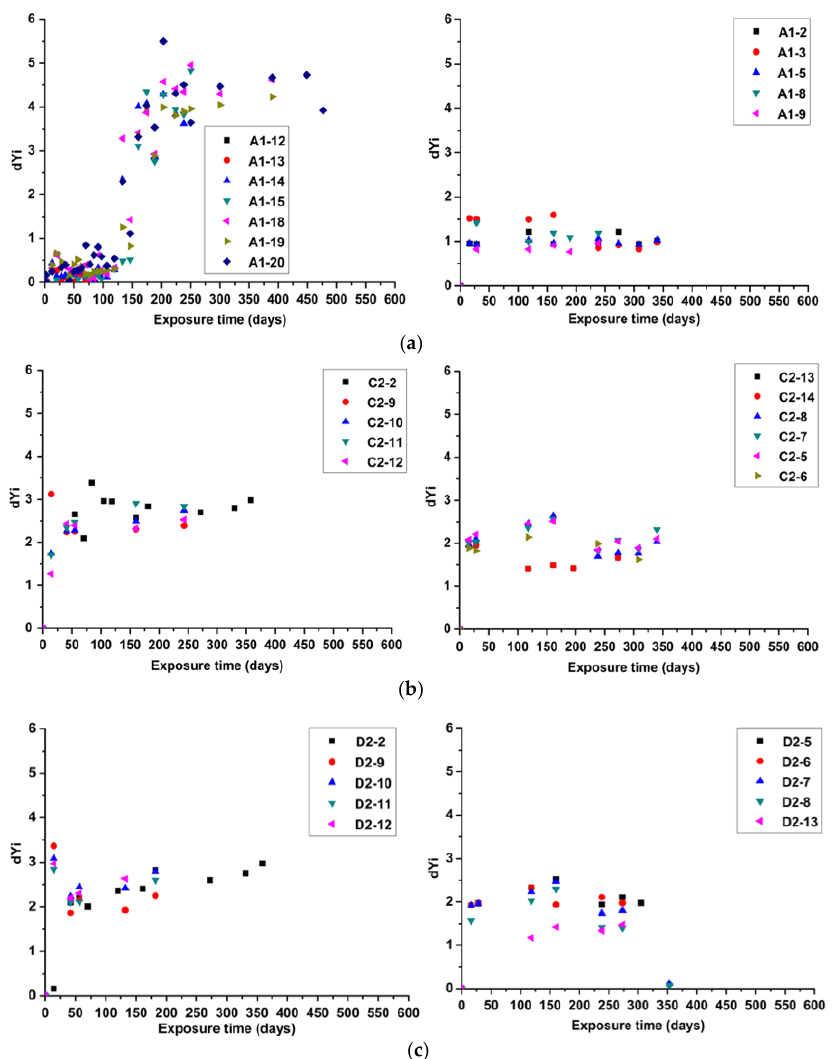
Figure 8. Evolution of color parameters (Δ a and Δ b ) of monolithic mirrors ( a ) A1, ( b ) C2, and ( c ) D2 paint coatings during exposure time at the desert site.